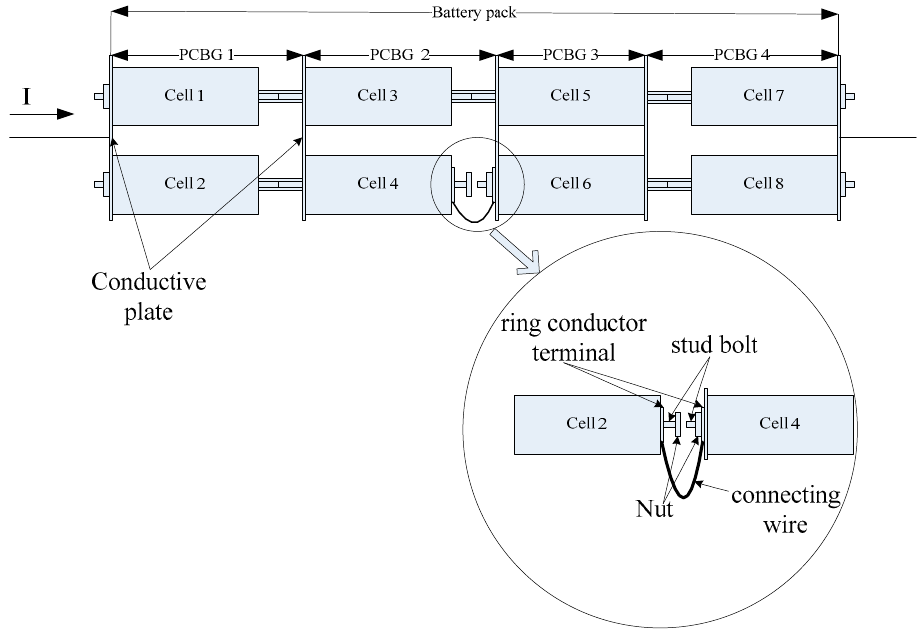
Figure 8. Schematic drawing of battery pack for loose contacting fault experiment.